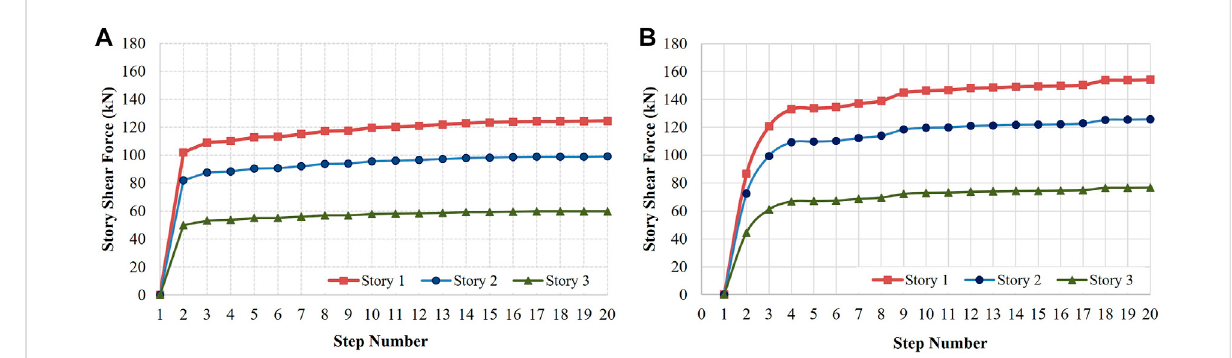
FIGURE 8 Story shear pro fi les: (A) x- and (B) y-direction.